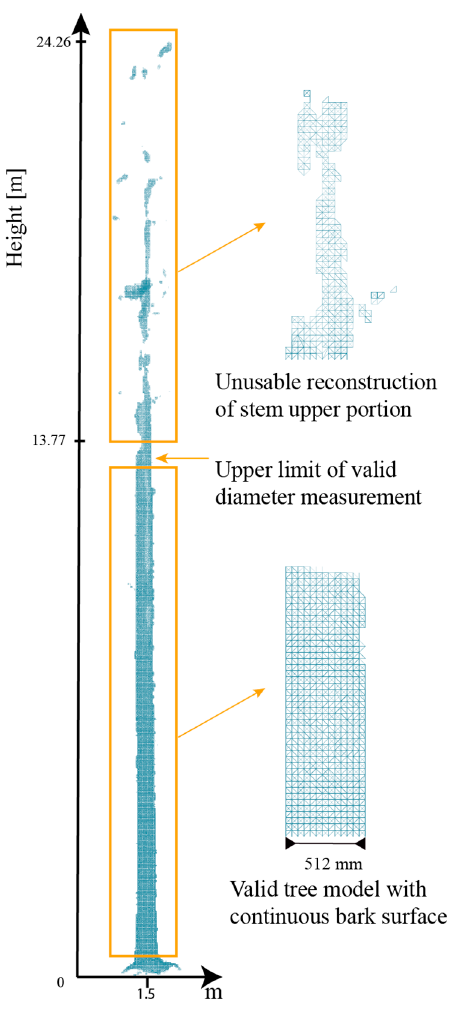
Figure 3. An example of a reconstructed stem, with the lower part continuous, (i.e., measurable surface), and the upper part fragmented (i.e., unsuitable for accurate measurements).